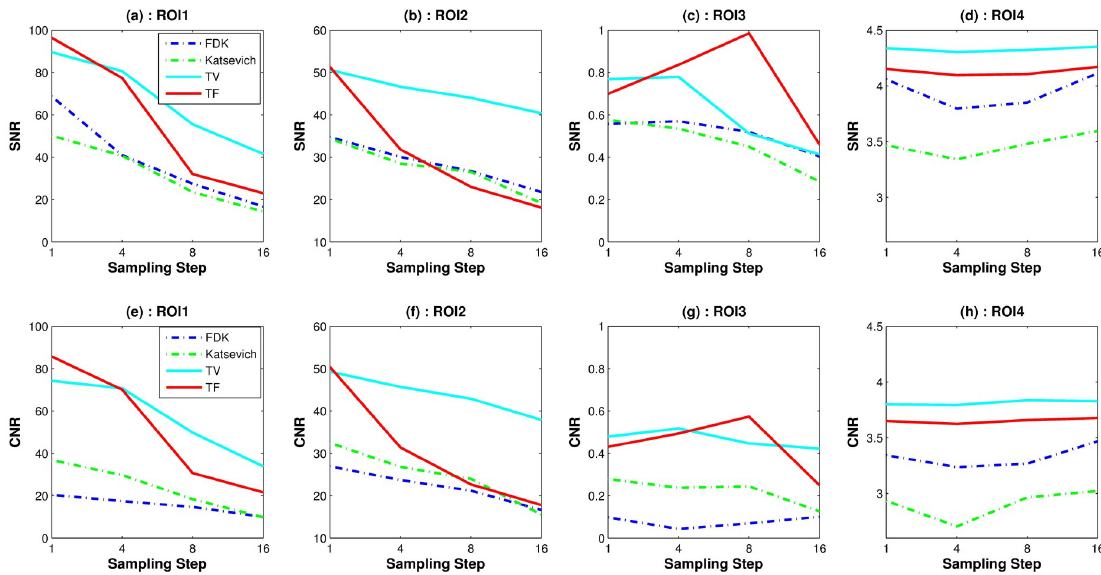
Fig 9. Image noise measures: SNR and CNR results for the various sampling step sizes. First row: SNR result, second row: CNR results.